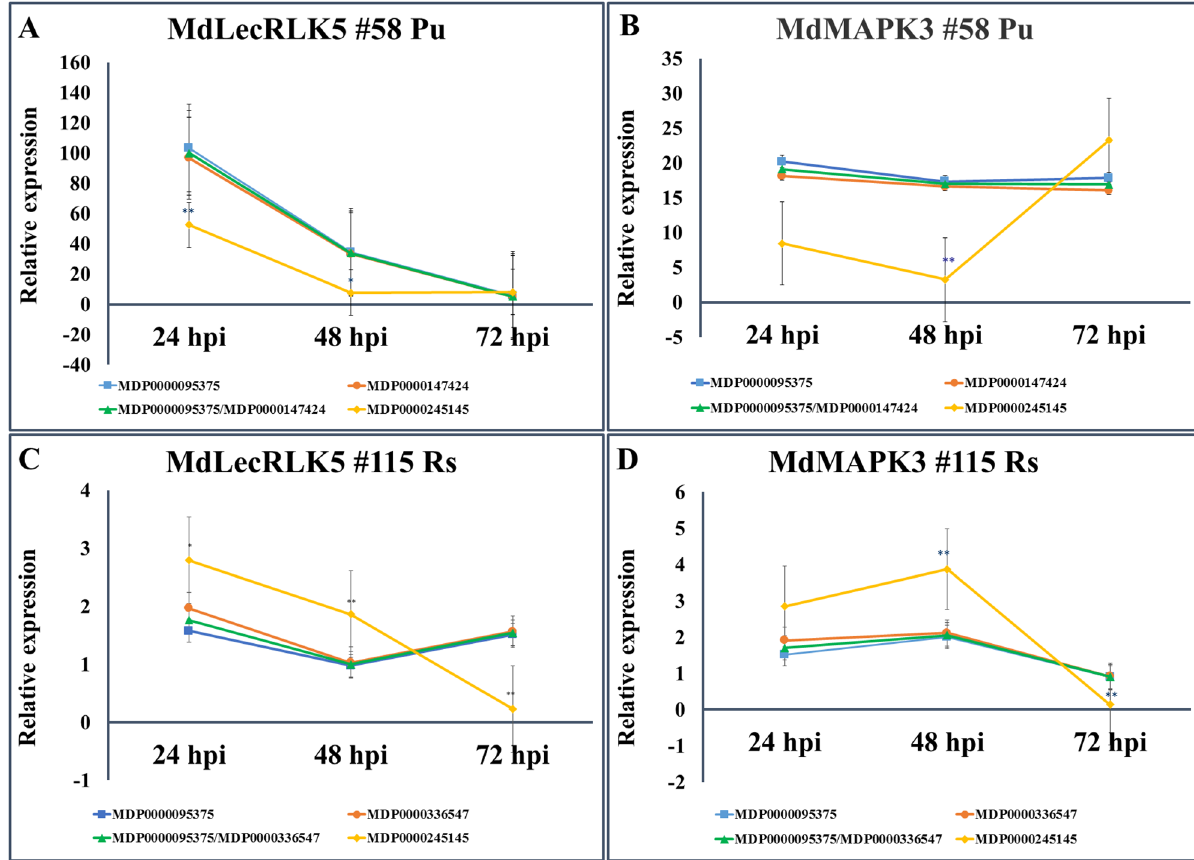
Fig 5. Normalized expressionpatterns of MdLecRLK5 and MdMAPK3 using selected referencegenes. (A) MdLecRLK5 and (B) MdMAPK3 in “#58 Pu” root tissues at 24, 48 and 72 hpi; (C) MdLecRLK5 and (D) MdMAPK3 in “#115 Rs” root tissues at 24, 48 and 72 hpi. The error bars are standard errors. T-test statistics were generatedby ANOVA among relativeexpressionlevels in the same sample. * P < 0.05, ** P < 0.01.